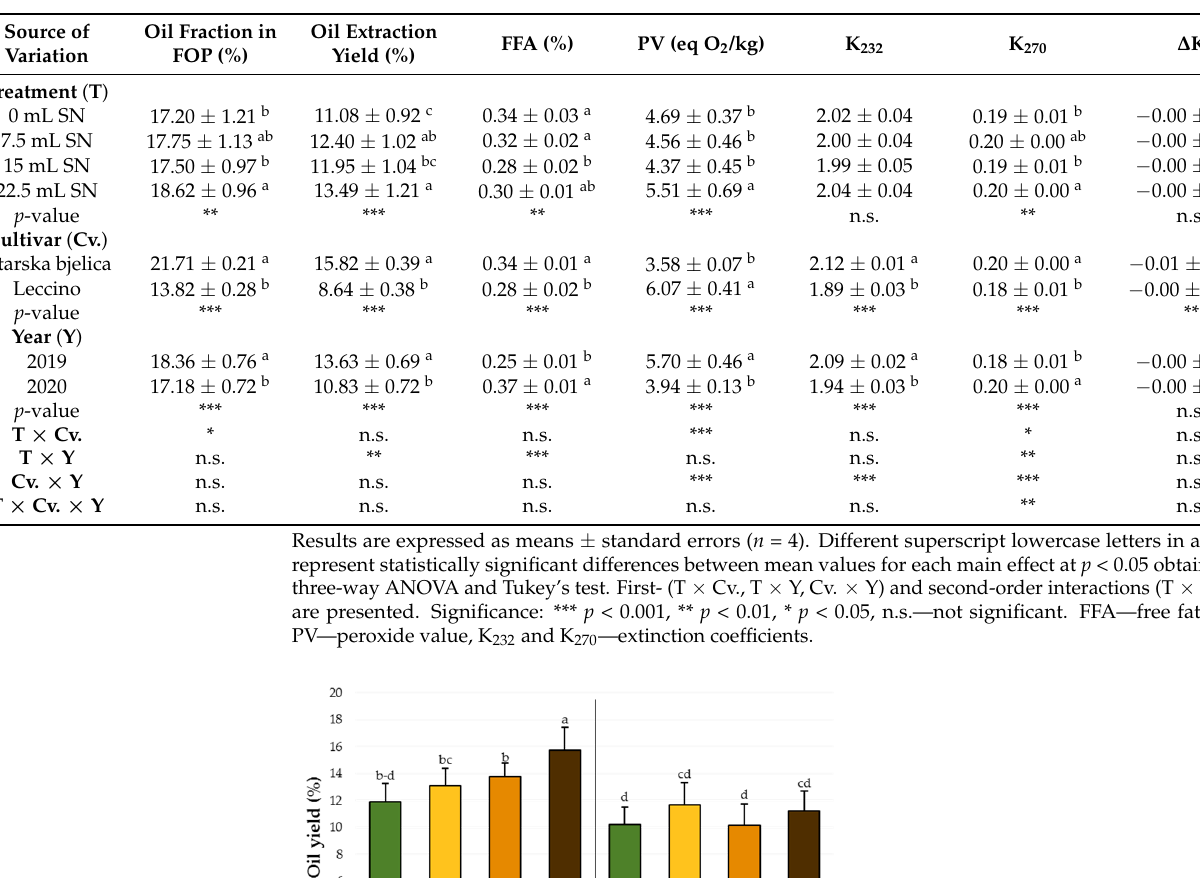
Table 4. The effect of treatment (T) (0, 7.5, 15, and 22.5 mL of applied SN foliar fertilizer per 1 L of water), cultivar (Cv.) (Istarska bjelica, Leccino), and collection year (Y) (2019, 2020) on oil fractions in fresh olive paste (FOP), oil extraction yield, and parameters of olive oil quality.